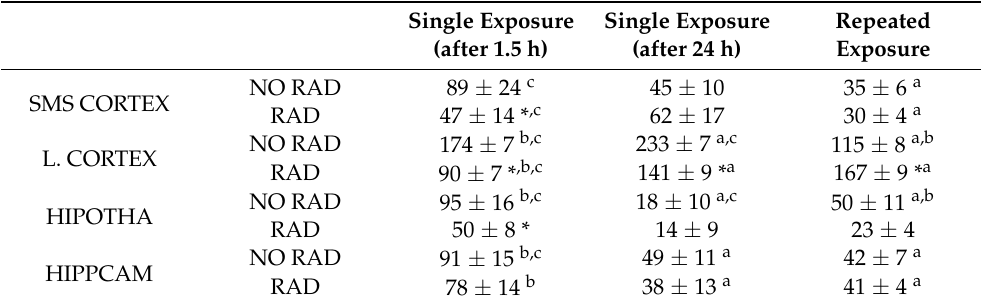
Two-way ANOVA (radiation × time) for each area: somatosensory cortex (SMS CORTEX), limbic cortex (L. COR- TEX), hypothalamus (HIPOTHA) and hippocampus (HIPPCAM) ( n = 15 samples/per group). *